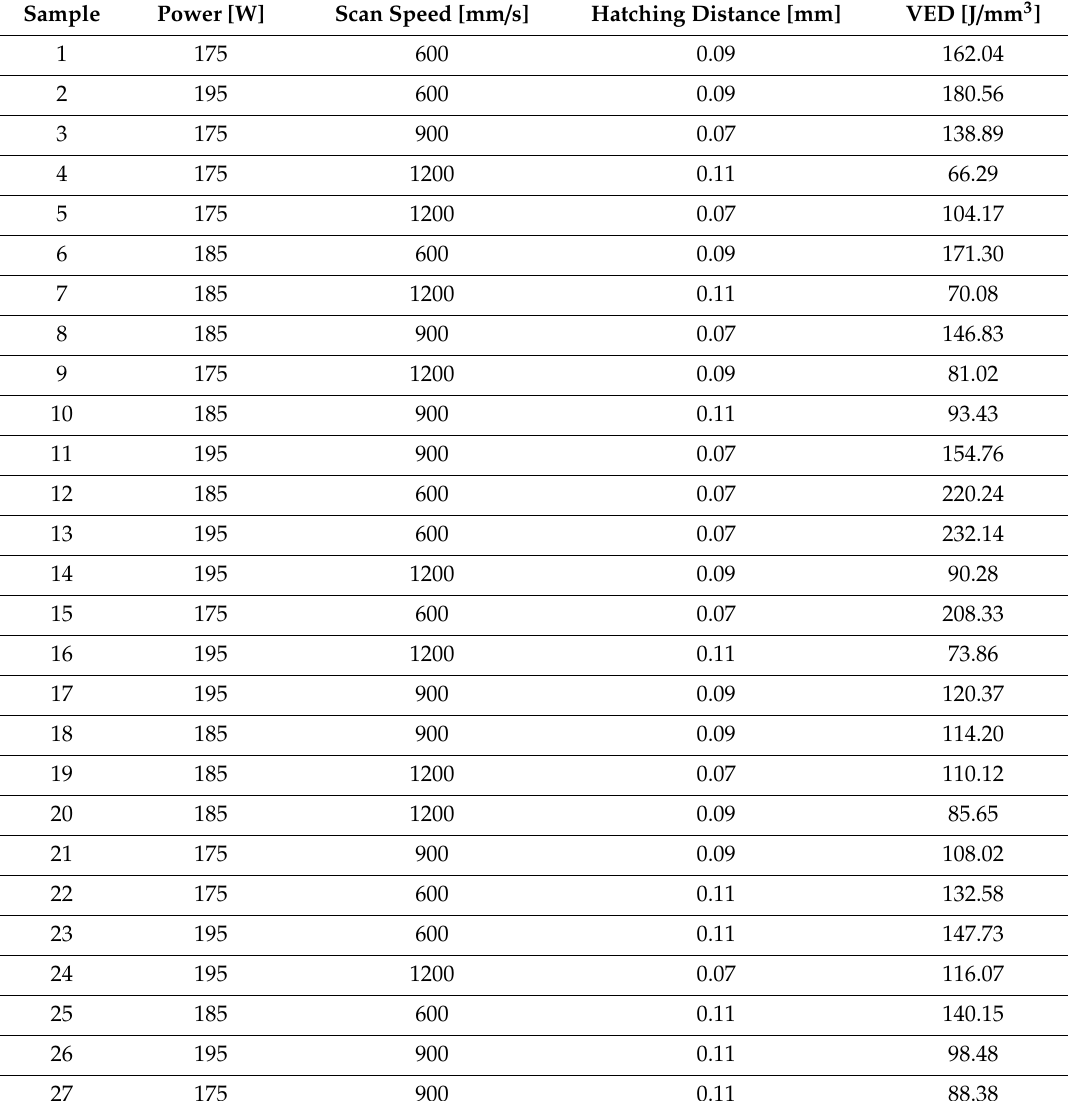
Table 2. Investigated combinations for the optimization study of the process parameters and relative volumetric energy density (VED)